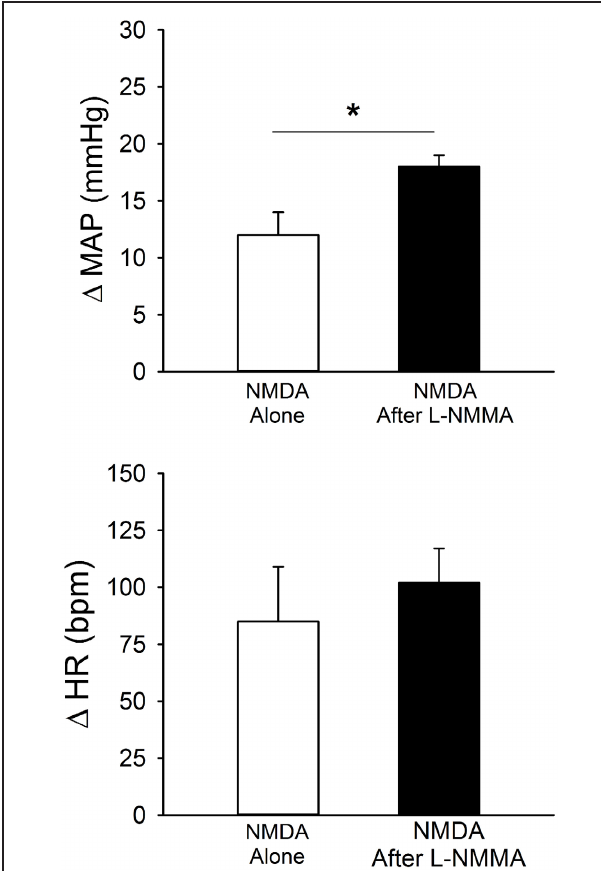
FIGURE 7 | Effects of bilateral blockade within the PVN of GABA A receptors with bicuculline (Bic, 1mM) on MAP and HR in conscious rats ( n = 6) alone (open bars) or after blockade of ionotropic glutamate receptors with kynurenic acid (Kyn, 40mM; filled bars). Bilateral microinjection of Bic alone produced significant increases in MAP and HR. Pressor and tachycardic responses to Bic were significantly attenuated by prior microinjection of Kyn ( ∗ p ≤ 0 .